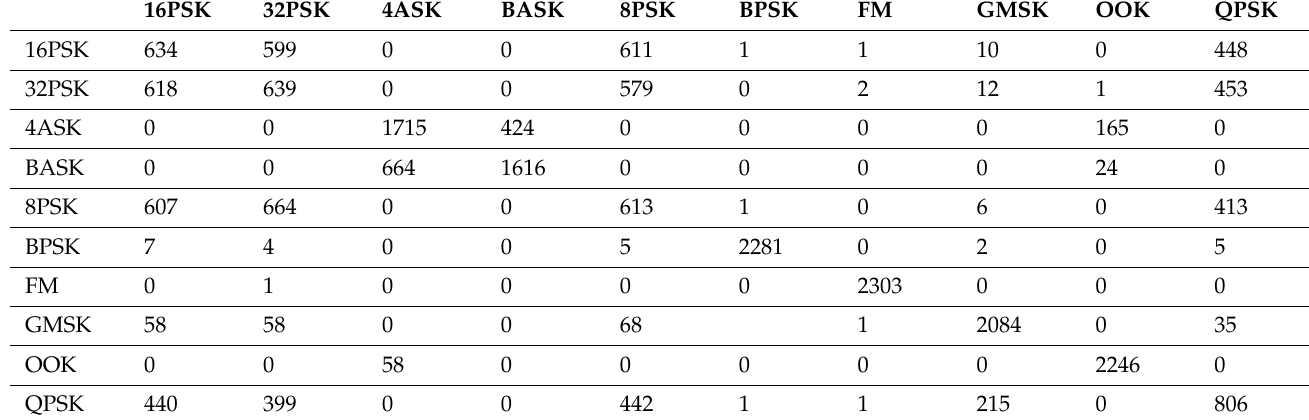
Table 4. Confusion matrix.